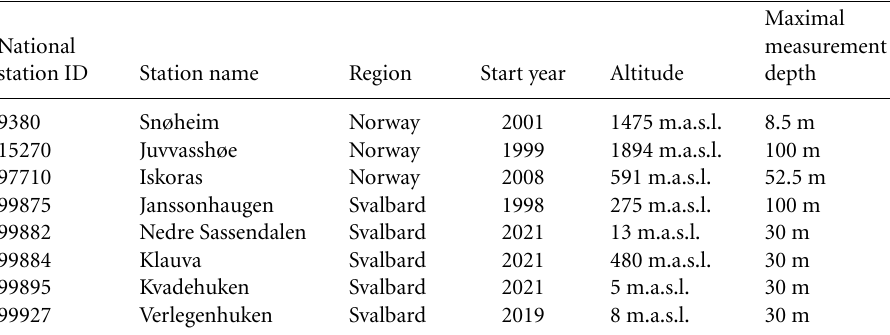
Table 1. List of permafrost stations available on https://cryo.met.no/ per July 2022.